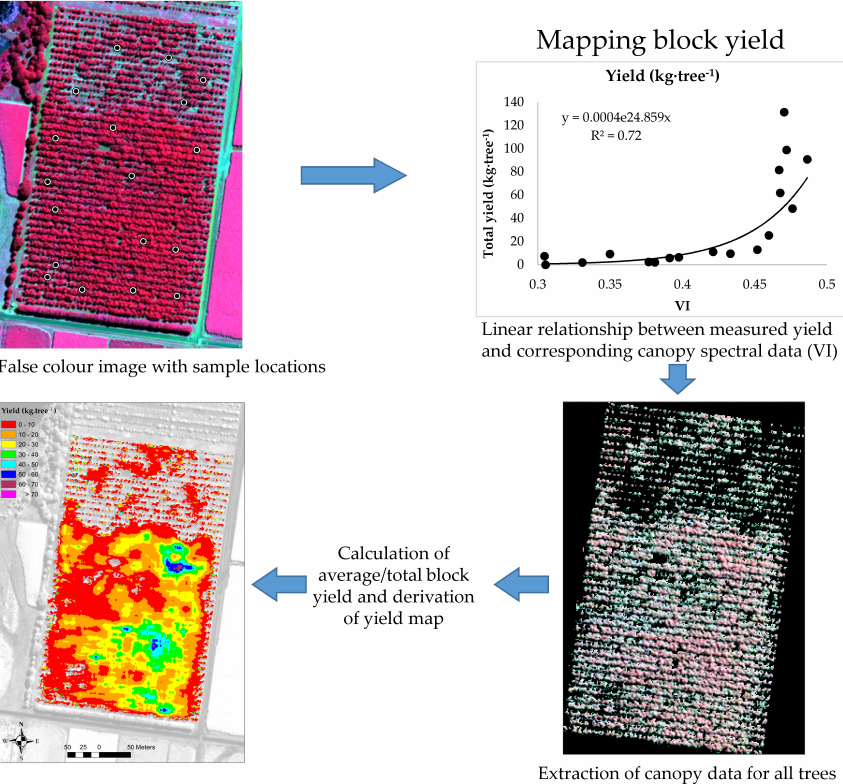
Figure 3. Process of deriving parameter specific map from WorldView-3 (WV3) imagery using the algorithm developed from the 18 sampled trees per block.